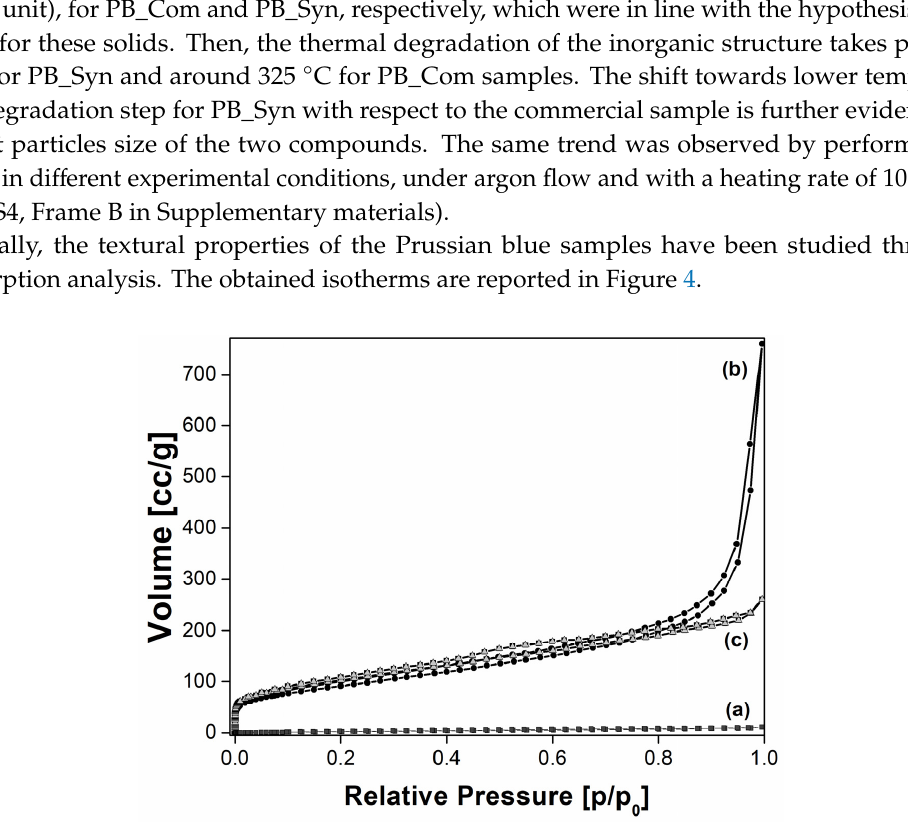
Figure 4. N 2 Physisorption at − 196 °C at relative pressures (p/p 0 ) from 1 × 10 − 7 to 1 of: PB_Com ( ■ , a ), PB_Syn ( • , b ), and PB_Acid ( ∆ , c ) samples.